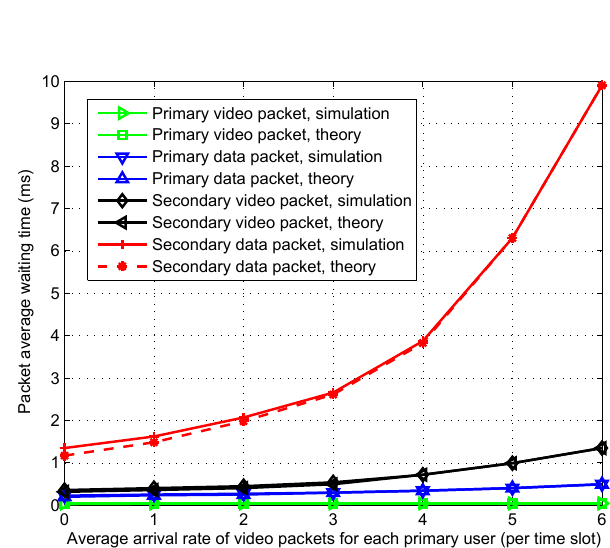
Figure 4. Experimental and analytical results of average waiting time of the primary and secondary video and data packets for first prioritization scheme in our proposed MAC scheme.